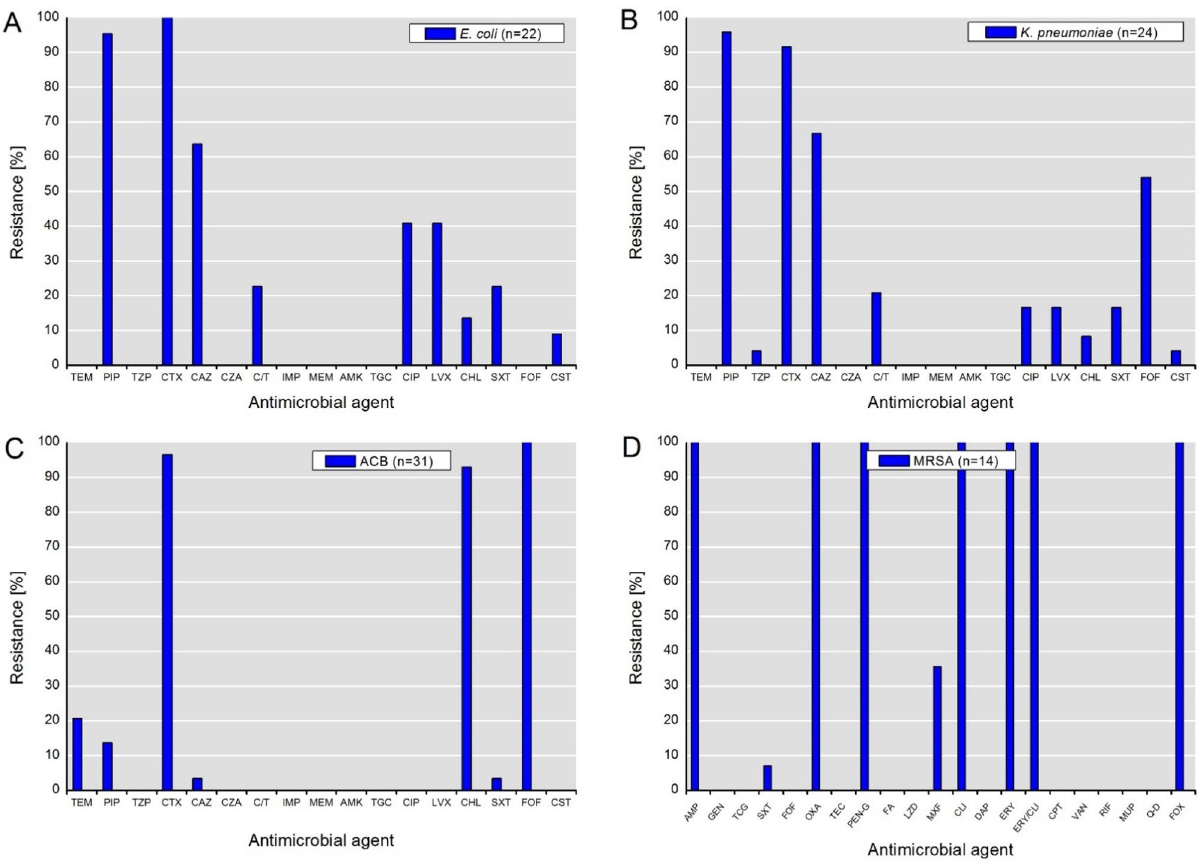
Figure 1. Phenotypic resistance to antimicrobial agents detected among isolates of ( A ) E. coli , ( B ) K. pneumoniae , ( C *) ACB complex and ( D **) MRSA. Abbreviations for antimicrobial agents: TEM temocillin, PIP piperacillin, TZP piperacillin-tazobactam, CTX cefotaxime; CAZ ceftazidime; CZA ceftazidime-avibactam; C/T ceftolozane-tazobactam; IMP imipenem, MEM meropenem, AMK amikacin, TGC tigecycline, CIP ciprofloxacin, LVX levofloxacin, CHL chloramphenicol, SXT sulfamethoxazole-trimethoprim, FOF fosfomycin, CST colistin, AMP ampicillin, GEN gentamicin; OXA oxacillin, TEC teicoplanin, PEN-G penicillin G, FA fusidic acid, LZD linezolid, DAP daptomycin, CPT ceftaroline,, VAN vancomycin, RIF rifampicin, MUP mupirocin, FOX cefoxitin; MXF moxifloxacin, CLI clindamycin; ERY erythromycin, Q-D synercid (quinupristin- dalfopristin). *Species of the ACB complex are considered intrinsically resistant to temocillin, cefotaxime, chloramphenicol and fosfomycin. **MRSA is considered intrinsically resistant to ampicillin, oxacillin, penicillin-G and